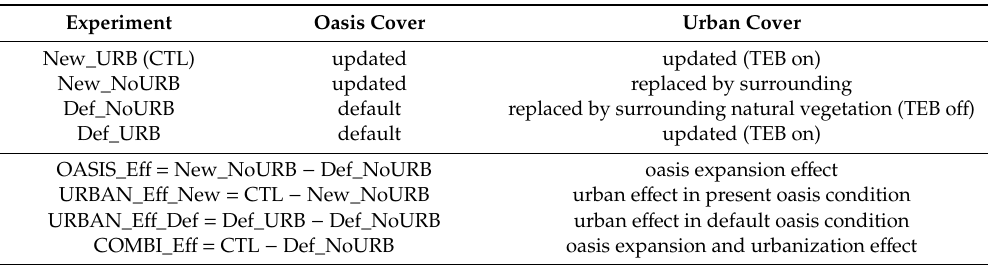
Table 1. Numerical experiments